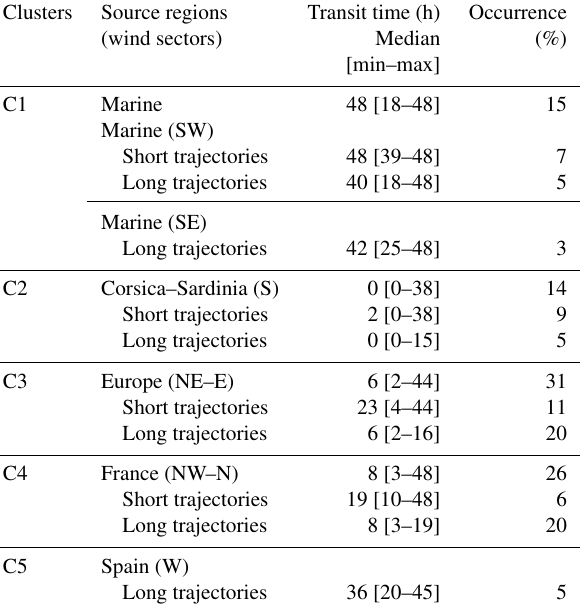
Table 2. Back-trajectory clusters for air masses observed at Ersa from June 2012 to June 2014. The transit time (expressed in hours) corresponds to the time spent since the last anthropogenic contami- nation, i.e. since air masses left continental